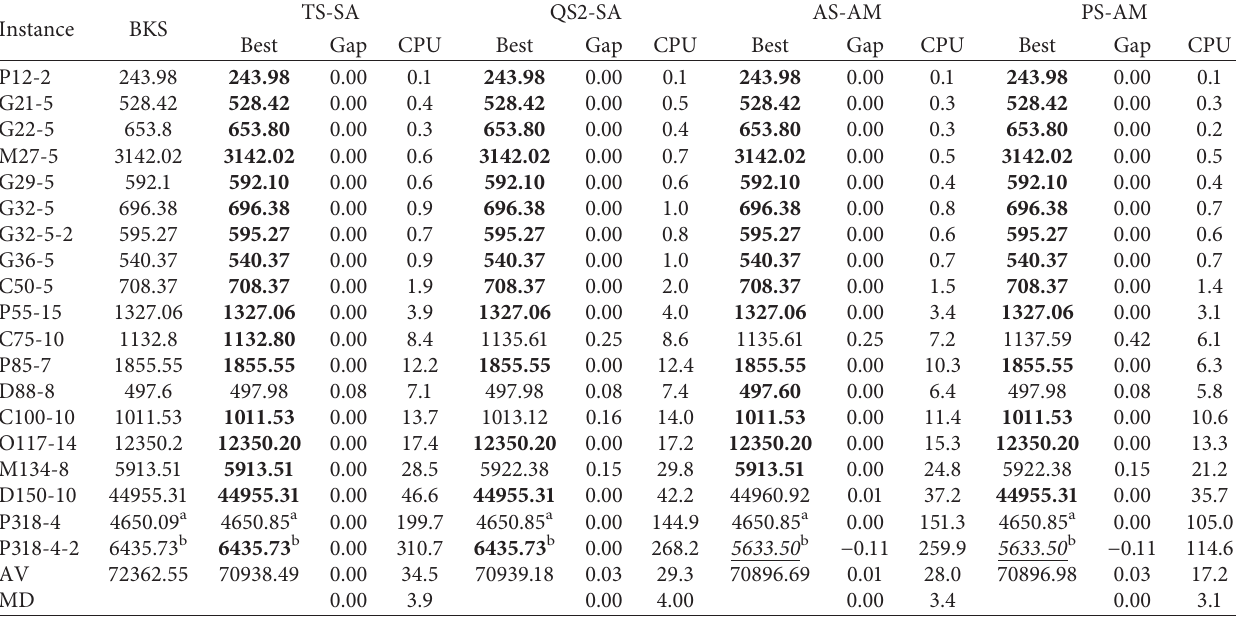
Table 8: Results for the CLRPSPD instances in Barreto set.